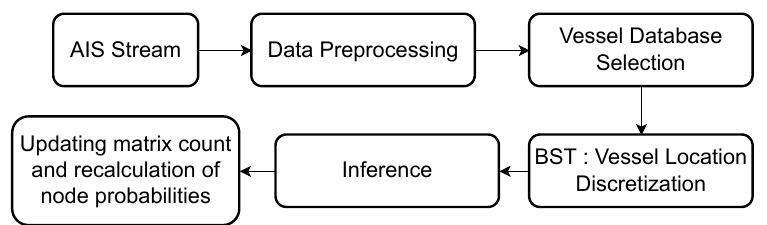
Figure 11. Inference pipeline.